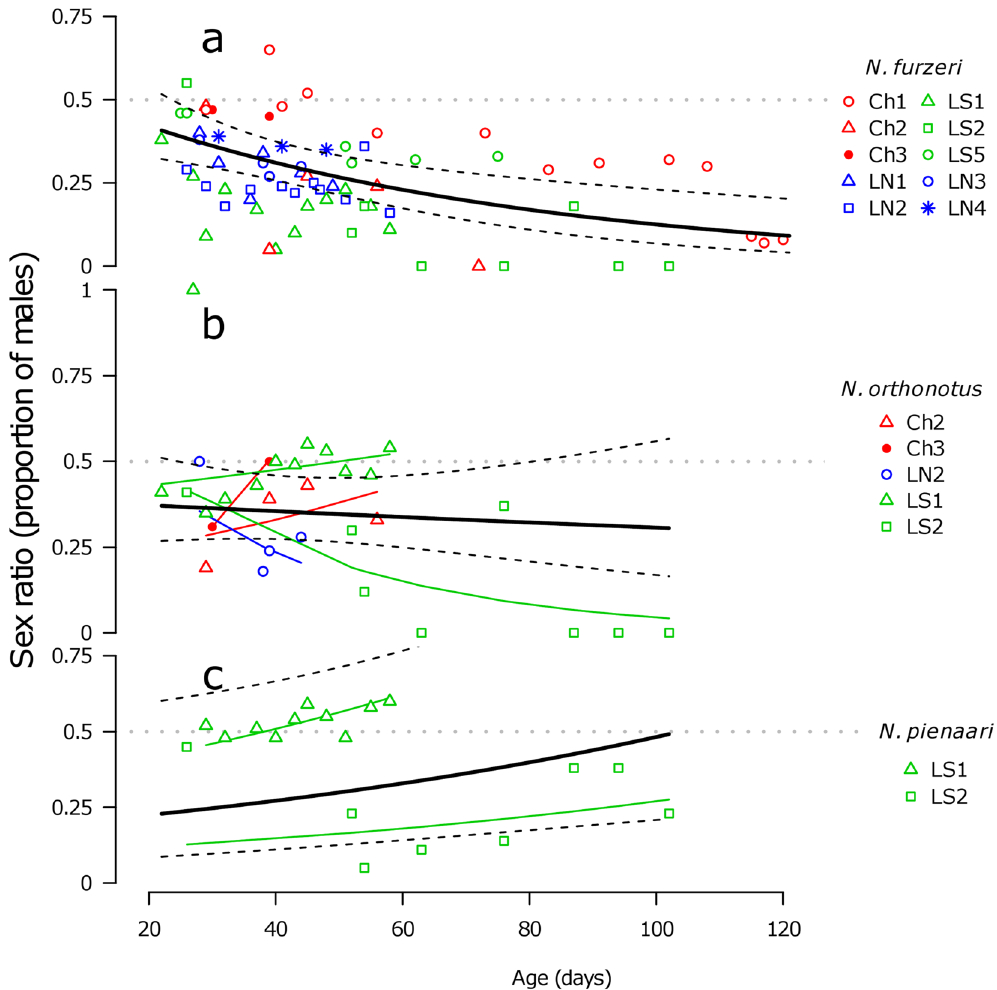
Figure 4. Temporal change in sex ratio. Seasonal change in sex ratio (proportion of males) in the three studied Nothobranchius species. In N. furzeri ( a ), the overall trend is negative, in N. orthonotus ( b ) inconclusive (population-specific) and in the two populations of N. pienaari ( c ), the proportion of males increased throughout the season. The thick black line gives overall trend estimated by the GLMM and dashed lines denote 95%